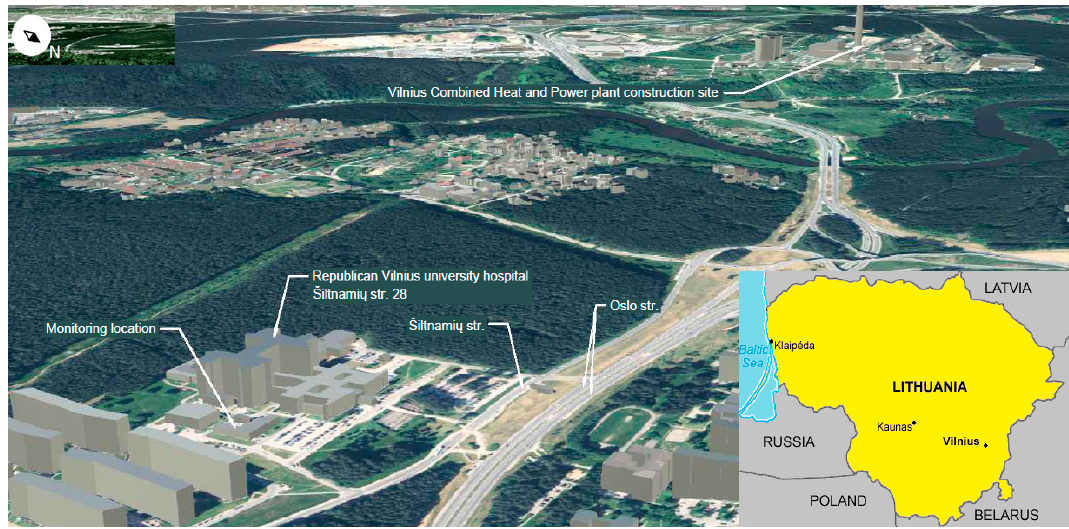
Figure 1. Map of Vilnius (source is www.google.com) Combined Heat and Power Plant construction site and PCDD/F measurement location (map of Lithuania).